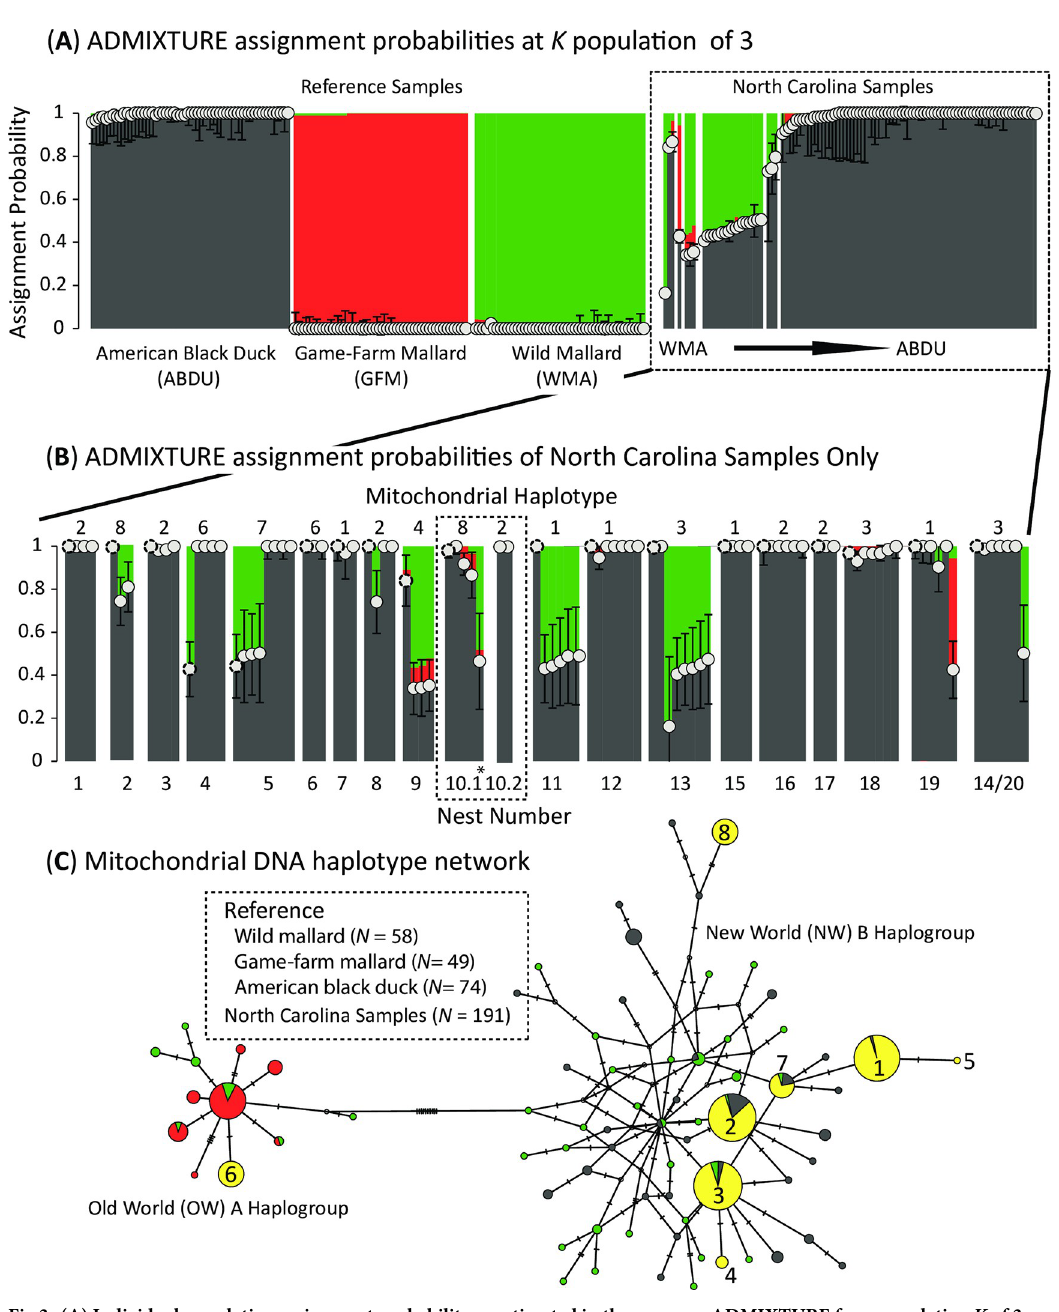
Fig 3. (A) Individual population assignment probability as estimated in the program ADMIXTURE for a population K of 3 model and based on a 16,819 independent bi-allelic ddRAD-seq autosomal SNP dataset for sampled reference American black ducks, game-farm mallards, and wild mallards, and 99 samples from North Carolina, USA, 2020–2021. We plot point ancestry and associated standard error assignment to the American black duck genetic cluster across samples. Any sample with standard error’s overlapping � 98% assignment to the American black duck was considered as genetically pure black duck. (B) Individual assignment probabilities of North Carolina samples only re-ordered by nest identity as established in co-ancestry clustering (Fig 2). Note that any nest with an associated female is at the start of each nest group, and denoted with a dotted outline on their point estimate. The major mtDNA haplotype and nest number associated with each group is provided above and below the assignment probability plot, respectively. Finally, (C) a reconstructed haplotype network for the mitochondrial DNA (mtDNA) control region sequenced across all reference and 192 North Carolina samples. Graduated circles represent sample size and dashes along network lines represent genetic distance between and within mitochondrial haplogroups. The previously identified Old World A (OW A) and New World B (NW B) haplogroups, as well as the eight haplotypes found across North Carolina samples are denoted.